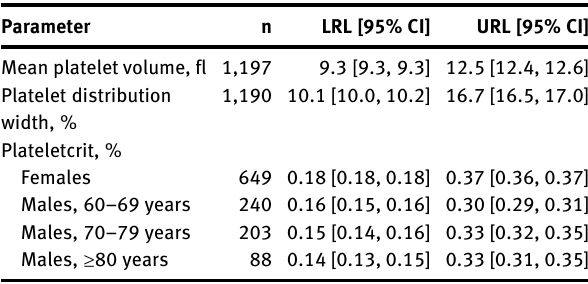
Table  : Direct reference intervals for platelet indices in